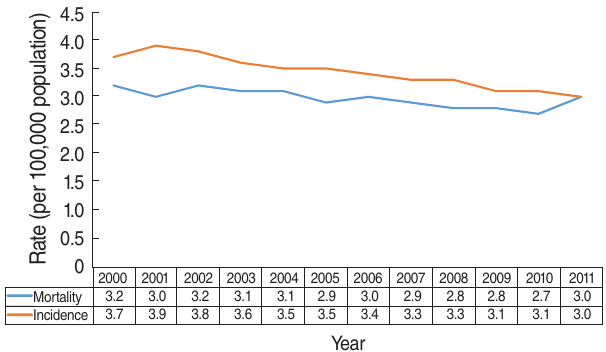
Figure 3. Age-adjusted incidence and mortality of esophageal cancer between 2000 and 2011 in the Korean population. Figure 1. Prostate cancer in Korean men. (A) Age-adjusted incidence and mortality between 2000 and 2011. (B) Age-adjusted incidence in 2001, 2003, 2005, 2007, 2009, and 2011 by age group.